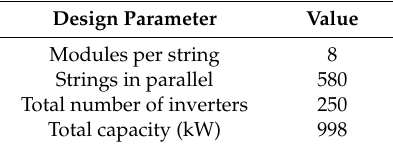
Table 4. Design details of PV modules, inverters and capacity.